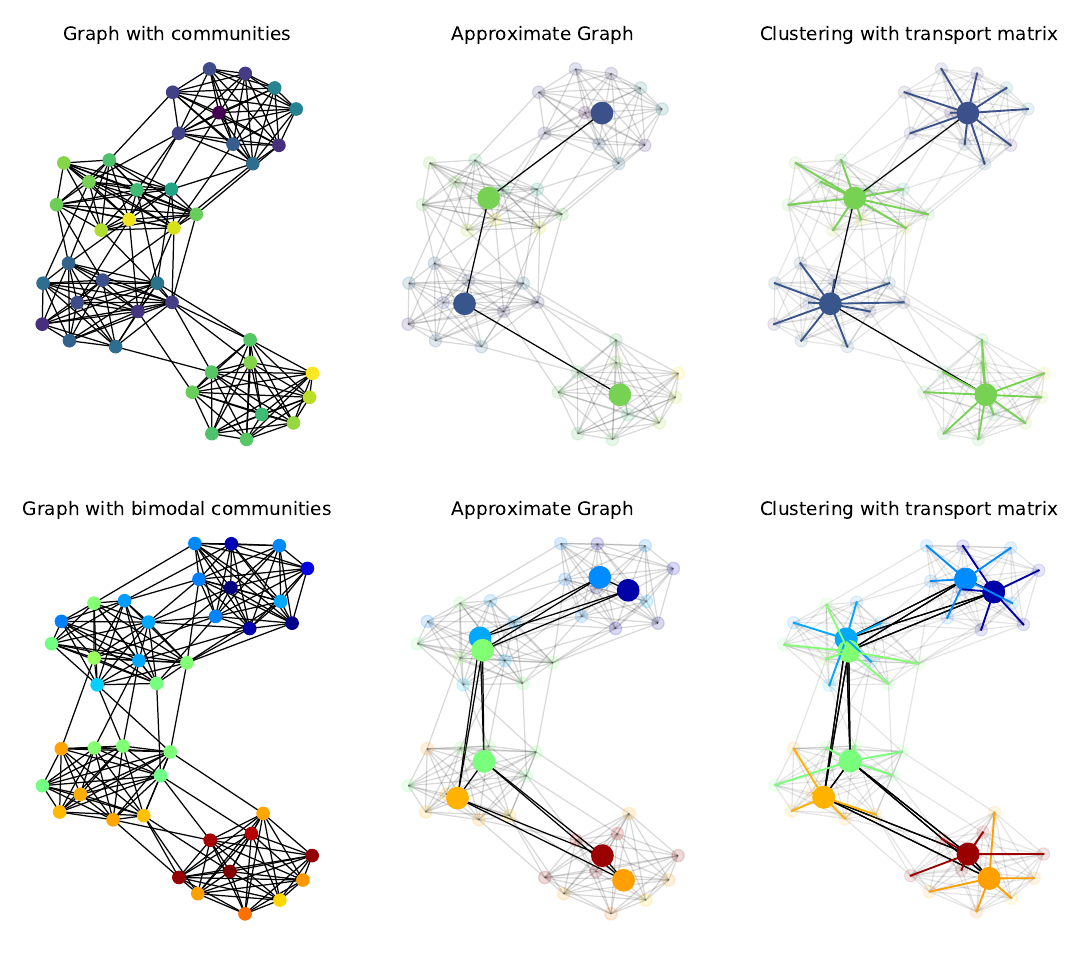
Figure 14. Example of community clustering on graphs using FGW . ( top ) Community clustering with four communities and uniform features per cluster. ( bottom ) Community clustering with four communities and bimodal features per cluster (and two nodes per cluster in the approximate